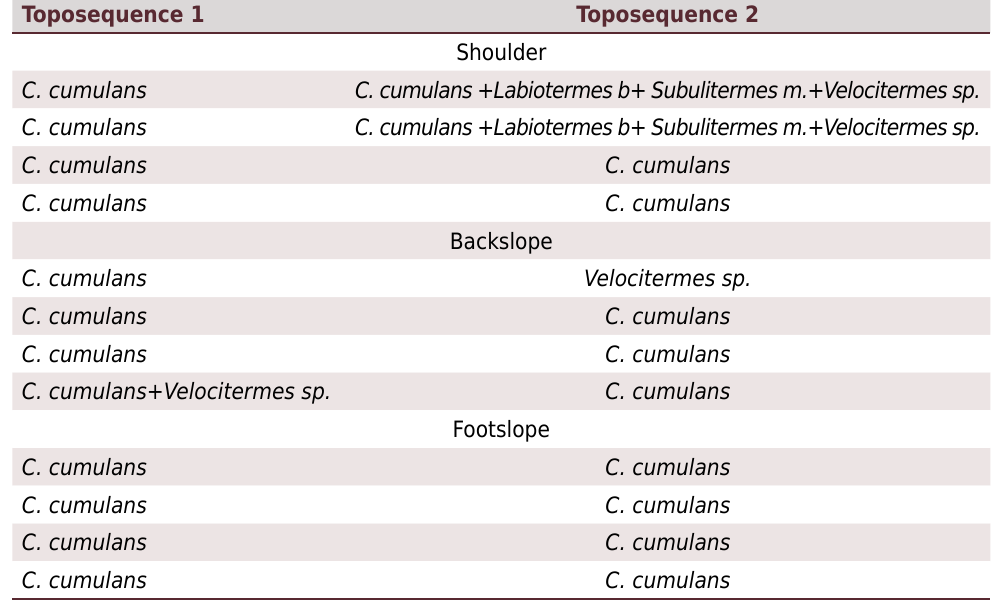
Table 1. Genera identified in termite mounds in slope thirds of